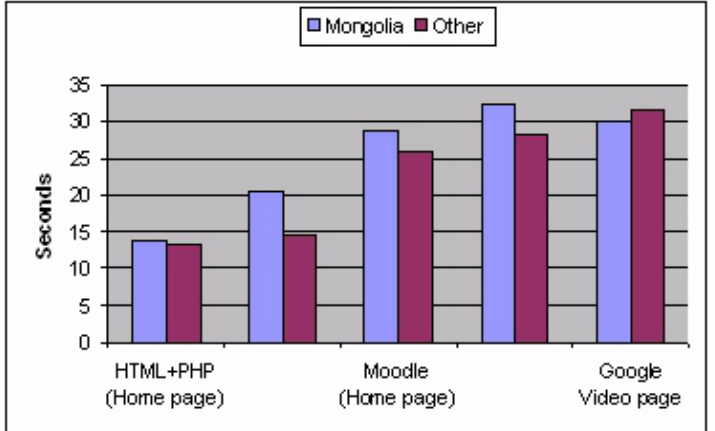
Figure 3. Browser loading speeds (Study A): Mongolia versus